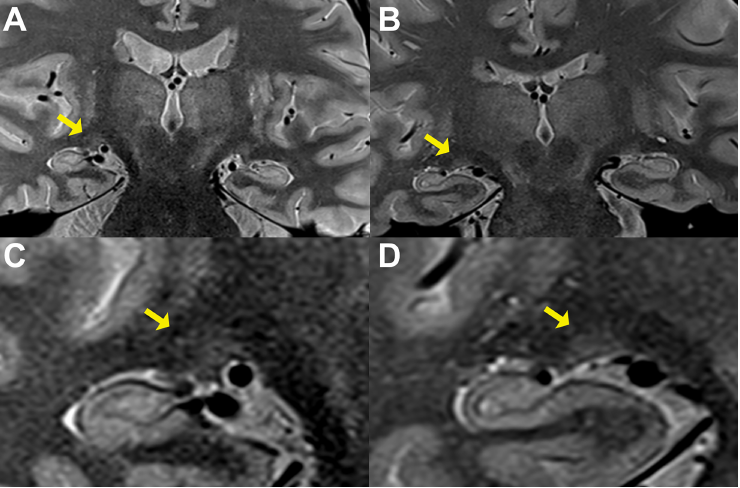
Fig 2. Magnetic resonance imaging scans showing the lateral geniculate nucleus (LGN). A , right LGN of a healthy individual (yellow arrow); B , right LGN of a glaucoma patient; C , zoomed-in image of the same LGN (yellow arrow) in image A; D , zoomed-in image of the same LGN (yellow arrow) in image